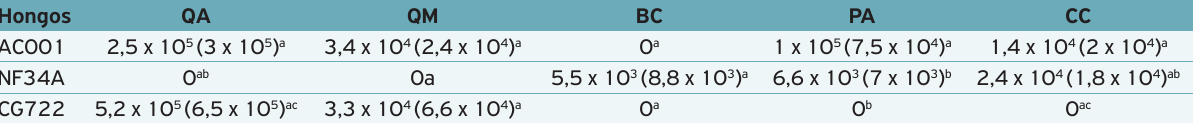
Tabla 2. Promedios de esporas recuperadas después de la incubación de diferentes aislados fúngicos en medios sólidos de cultivo variados después de siete días de